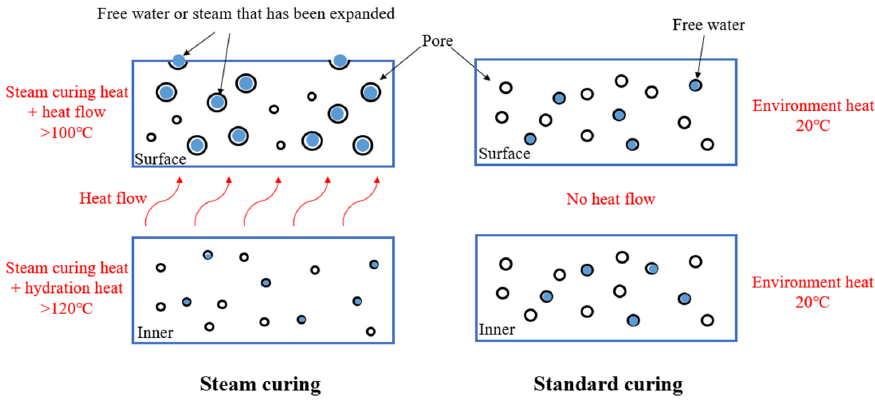
Figure 4. The heat damage of steam ‐ cured concrete